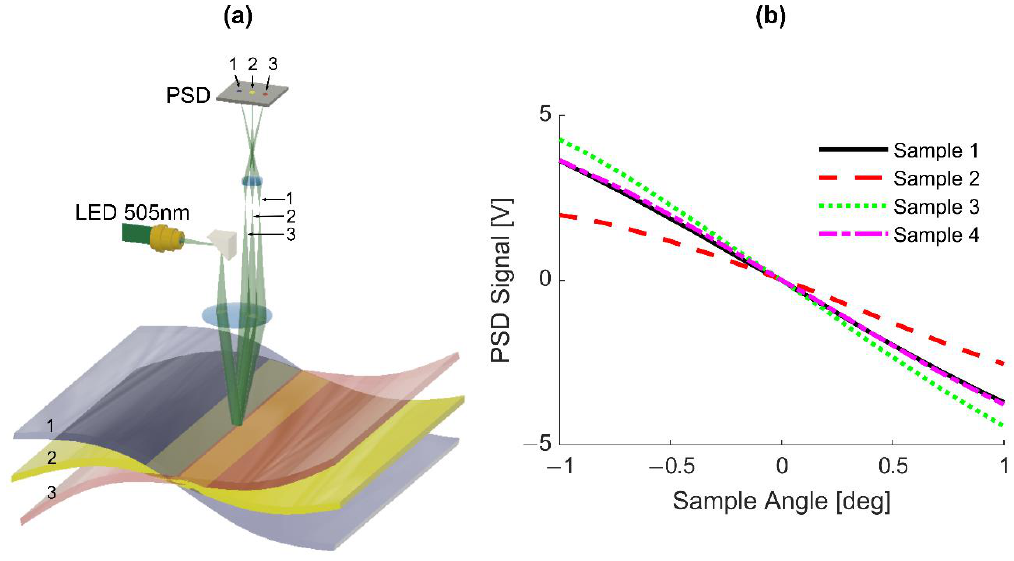
Figure 3. DACS operating principle for angle correction. ( a ) Sample surface angle measurement concept showing how different surface angles map to different locations on a PSD. ( b ) PSD signal output dependence on surface angle for different composite surfaces (samples correspond to their photographs in Figure 2c).